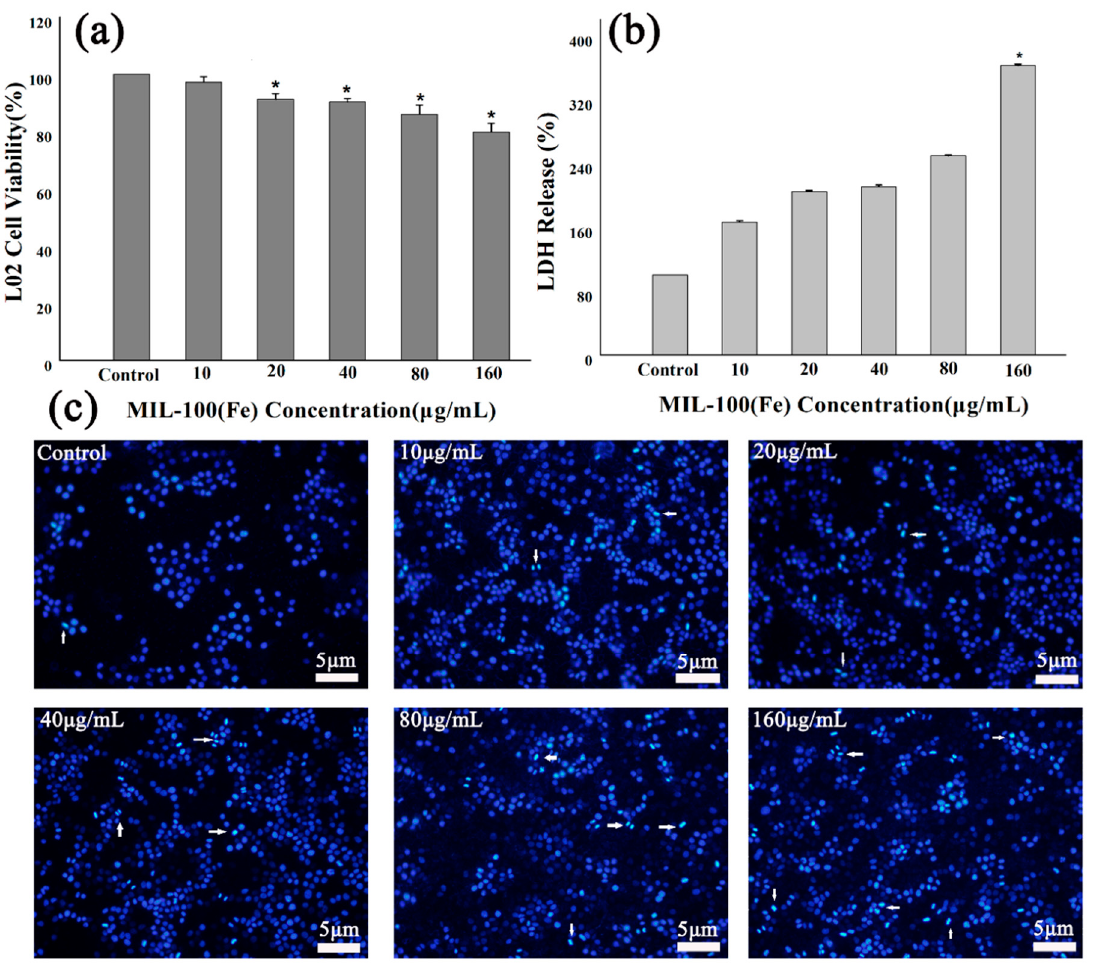
Figure 4. Effects of MIL-100(Fe) on HL-7702 cells’ viability and morphology: ( a ) MTT assay data, presented as mean ± SD of viability% of three independent experiments; ( b ) the effect of MIL-100(Fe) on LDH release of HL-7702 cells; ( c ) an evaluation of HL-7702 cells nuclear morphology by DAPI staining. (* p < 0.05 vs. Control.)